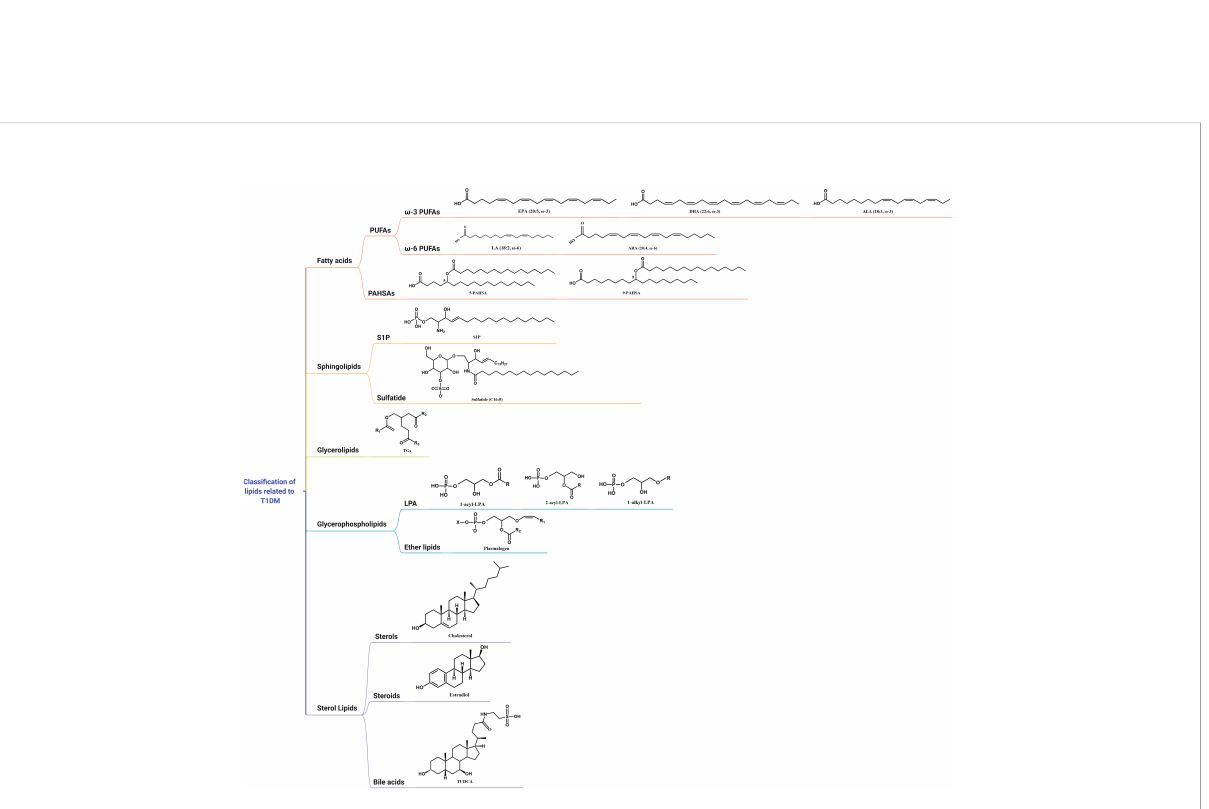
FIGURE 1 Classi fi cation and structure of lipids related to